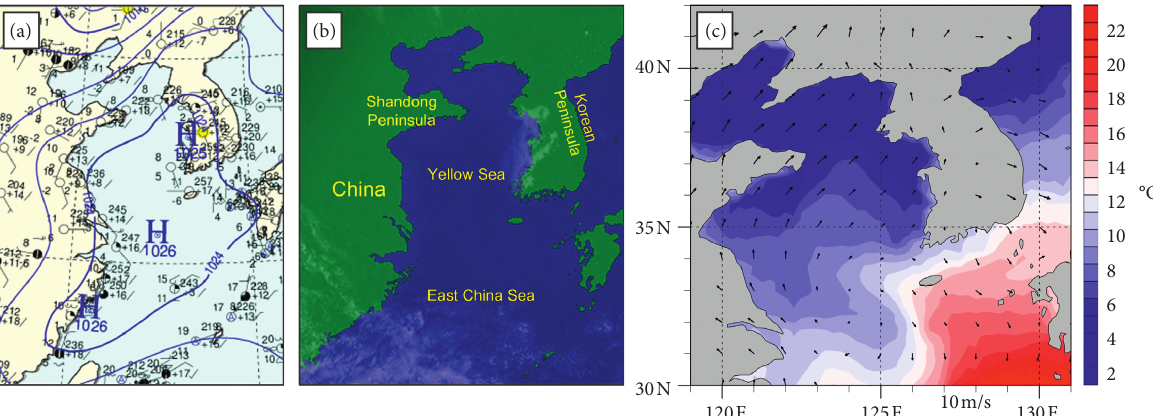
Figure 2: Korea Meteorological Administration (KMA) surface synoptic chart (a), Multifunctional Transport Satellite (MTSAT) visible image (b), and 10m wind vectors over the sea and SST (c) at 00UTC, 31 March 2011.